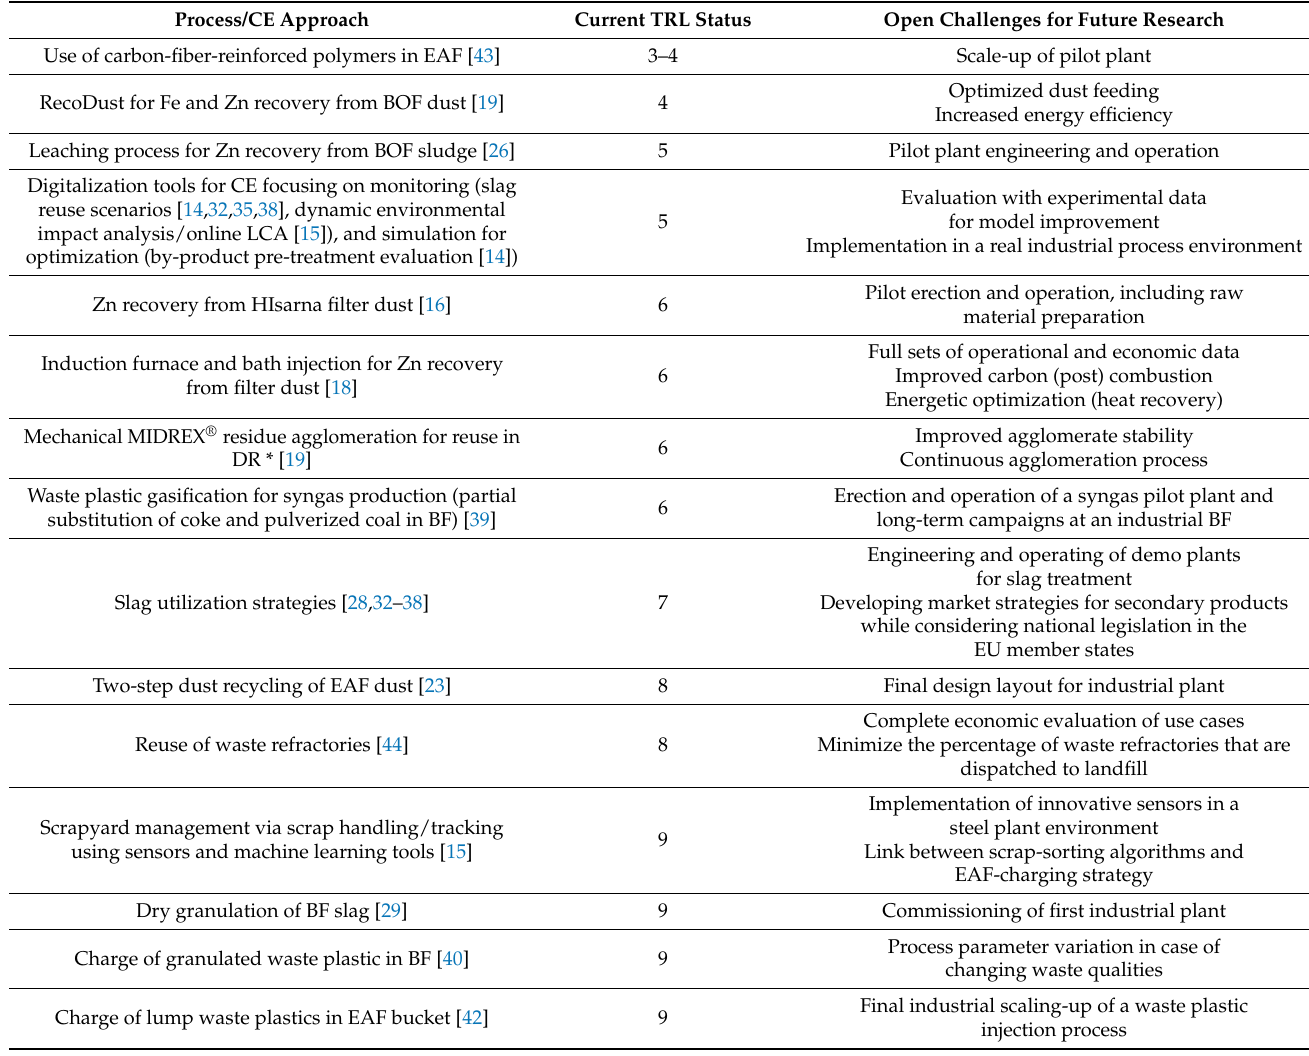
Table 2. Current technological development statuses and open challenges of the latest ongoing European research initiatives on CE approaches in the steel